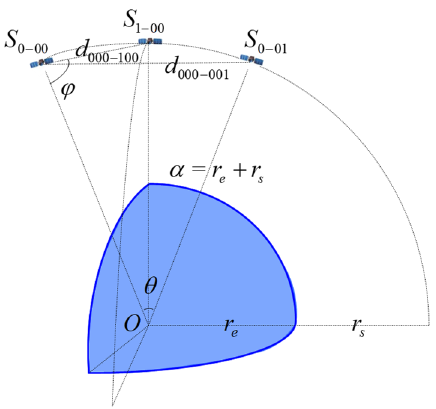
Figure 7. ISL with the closest communication distance between adjacent orbital planes.